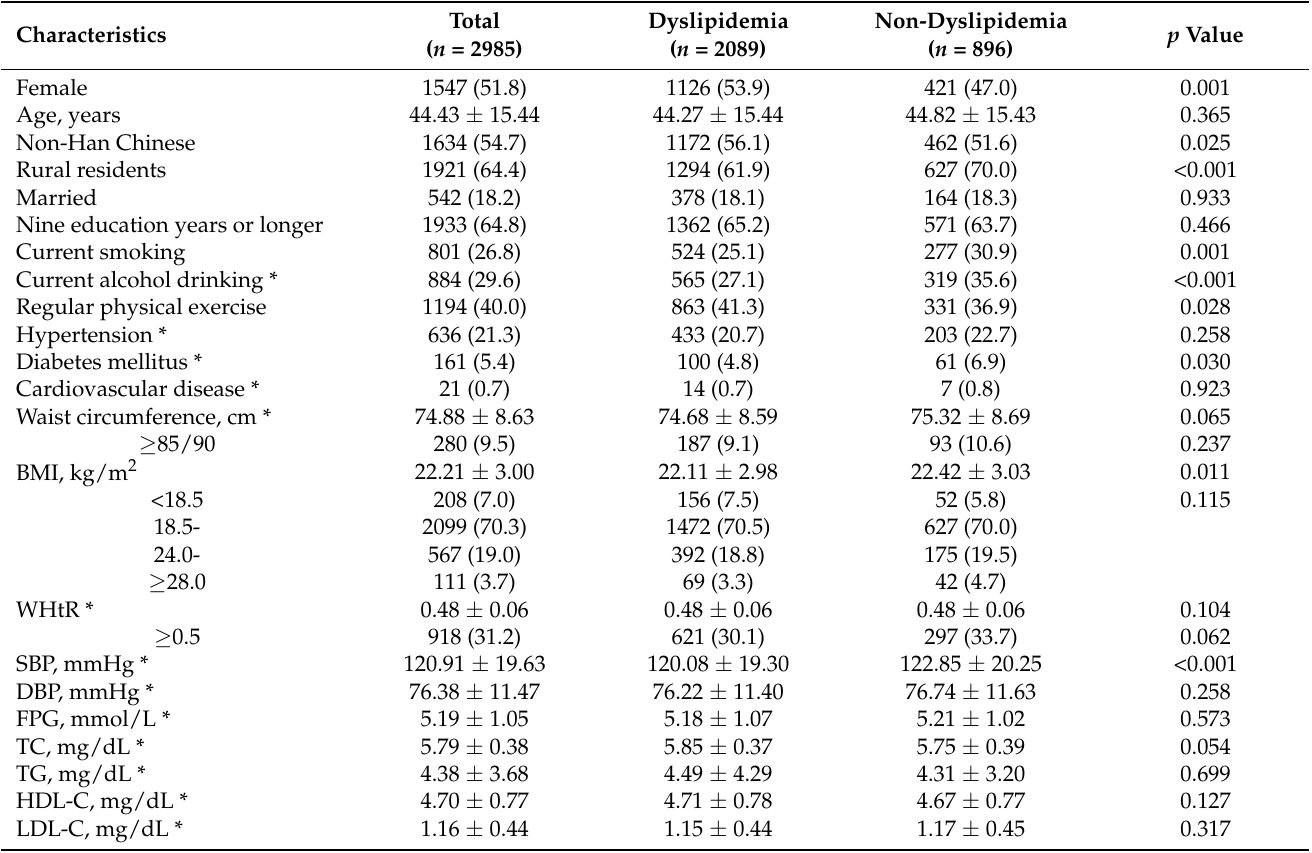
Table 1. Baseline characteristics of subjects from this cohort by incident dyslipidemia